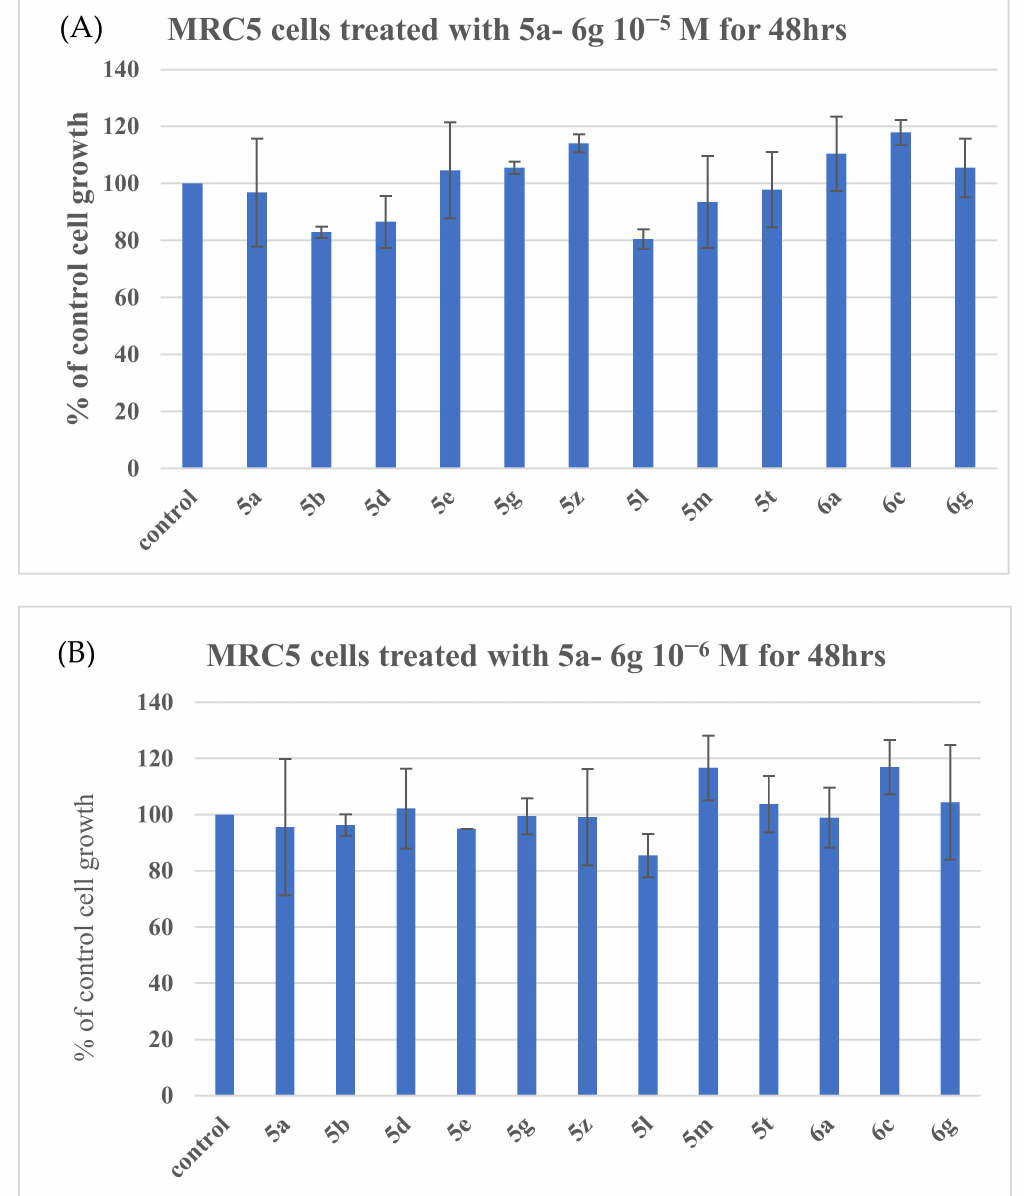
Figure 11. Assessment of cell proliferation of MRC-5 cells exposed to different compounds in culture. MRC-5 cells grown in culture were separately incubated with each of the compounds at concentrations 1 × 10 − 5 M (10 µ M) ( panel A ) and 1 × 10 − 6 M (1 µ M) ( panel B ) for 48 h